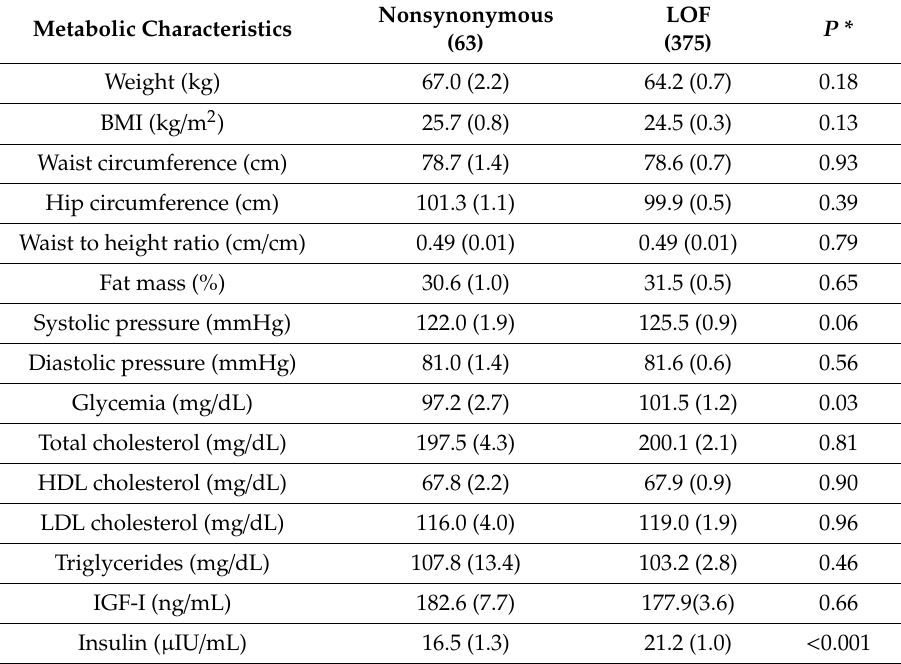
Table 3. Metabolic characteristics by BRCA variant types in 438 female carriers.